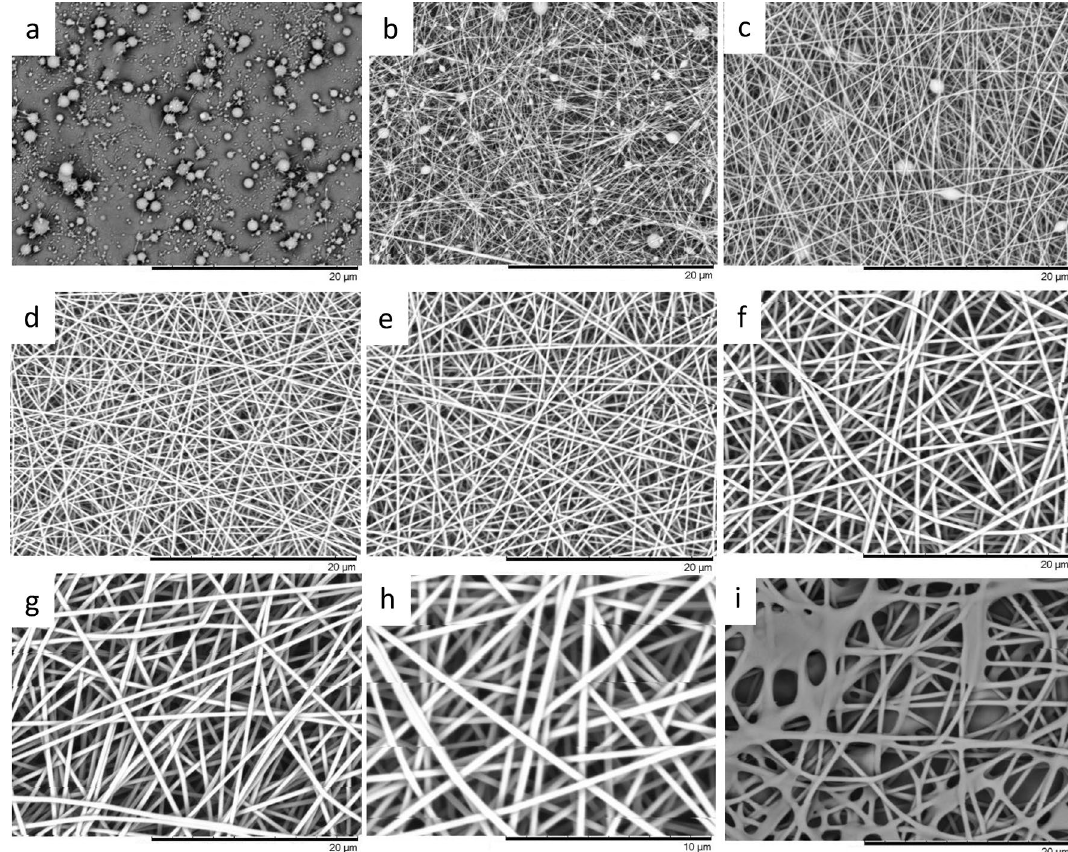
Figure 2. SEM micrographs of electro-spun fibers produced using solutions with polymer concentrations corresponding to ( a ) 2%; ( b ) 4%; ( c ) 6%; ( d ) 8%; ( e ) 10%; ( f ) 12%; ( g ) 14% wt/vol% PAN in DMSO that were electro-spun at 55 °C. ( h ) Represents a higher magnification of the 12% PAN solution that was electro-spun at 55 °C. ( i ) Corresponds to the 12% PAN solution that was electro-spun at 25 °C. PAN concentration in DMSO